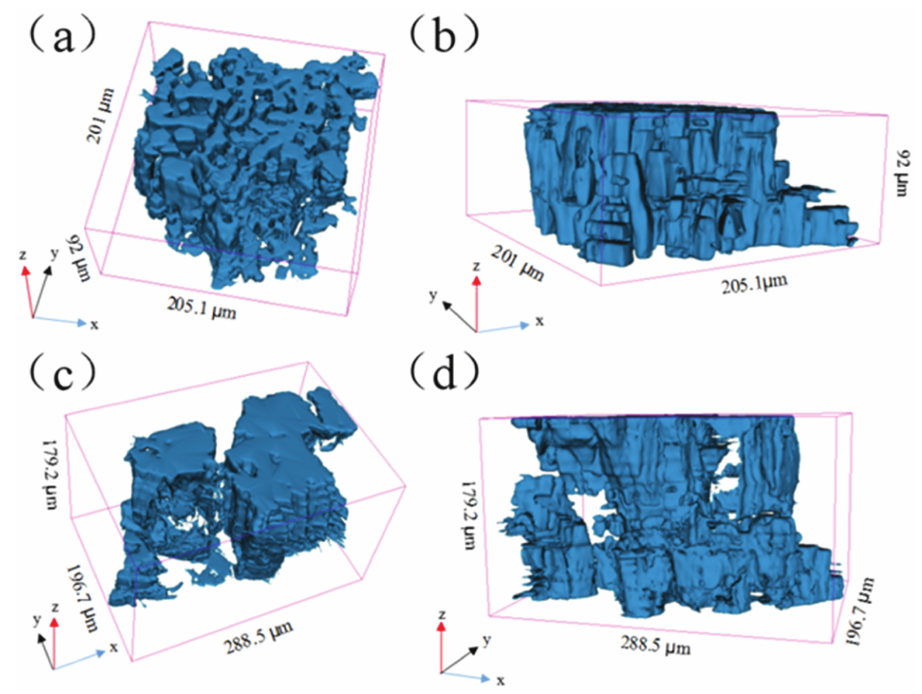
Figure 5: 3D microstructure of magnetite in vanadium-titanium sinter (a),(b) and in traditional sinter (c),(d).